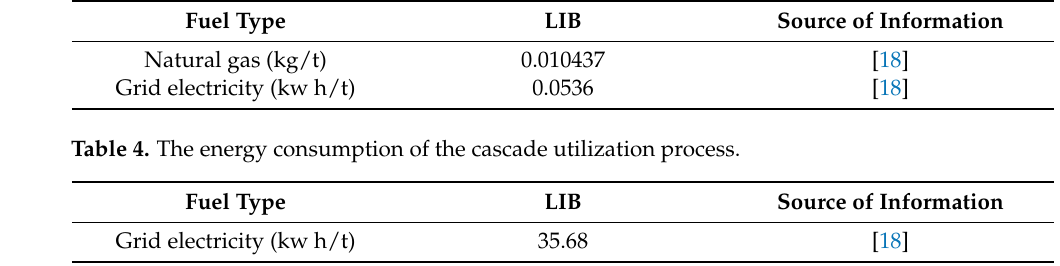
Table 3. The energy consumption of the pre-treatment process.